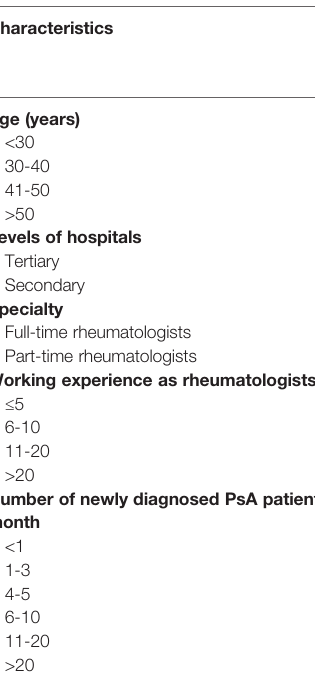
TABLE 1 | Characteristics of